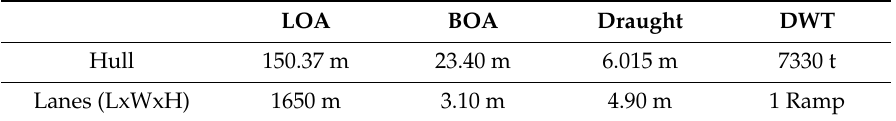
Table 2. Ship main particulars.